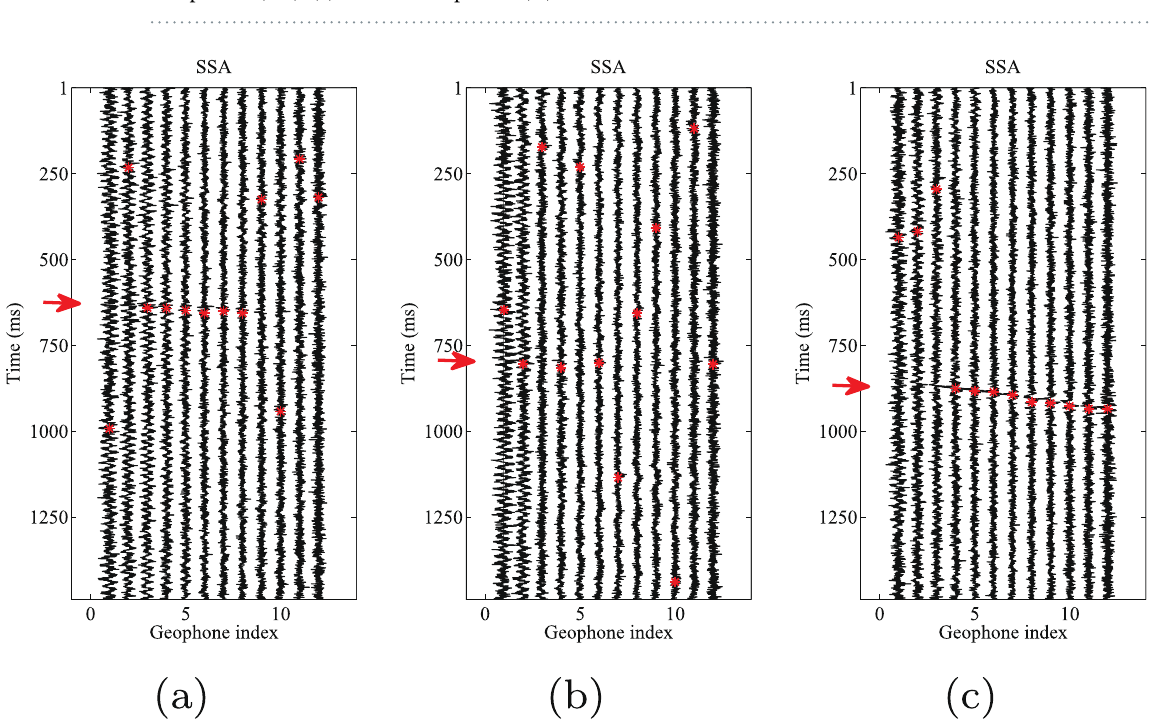
Figure 15. Arrival picking results using SSA. ( a ) Horizontal component (H1). ( b ) horizontal component (H2). ( c ) Vertical component (V).